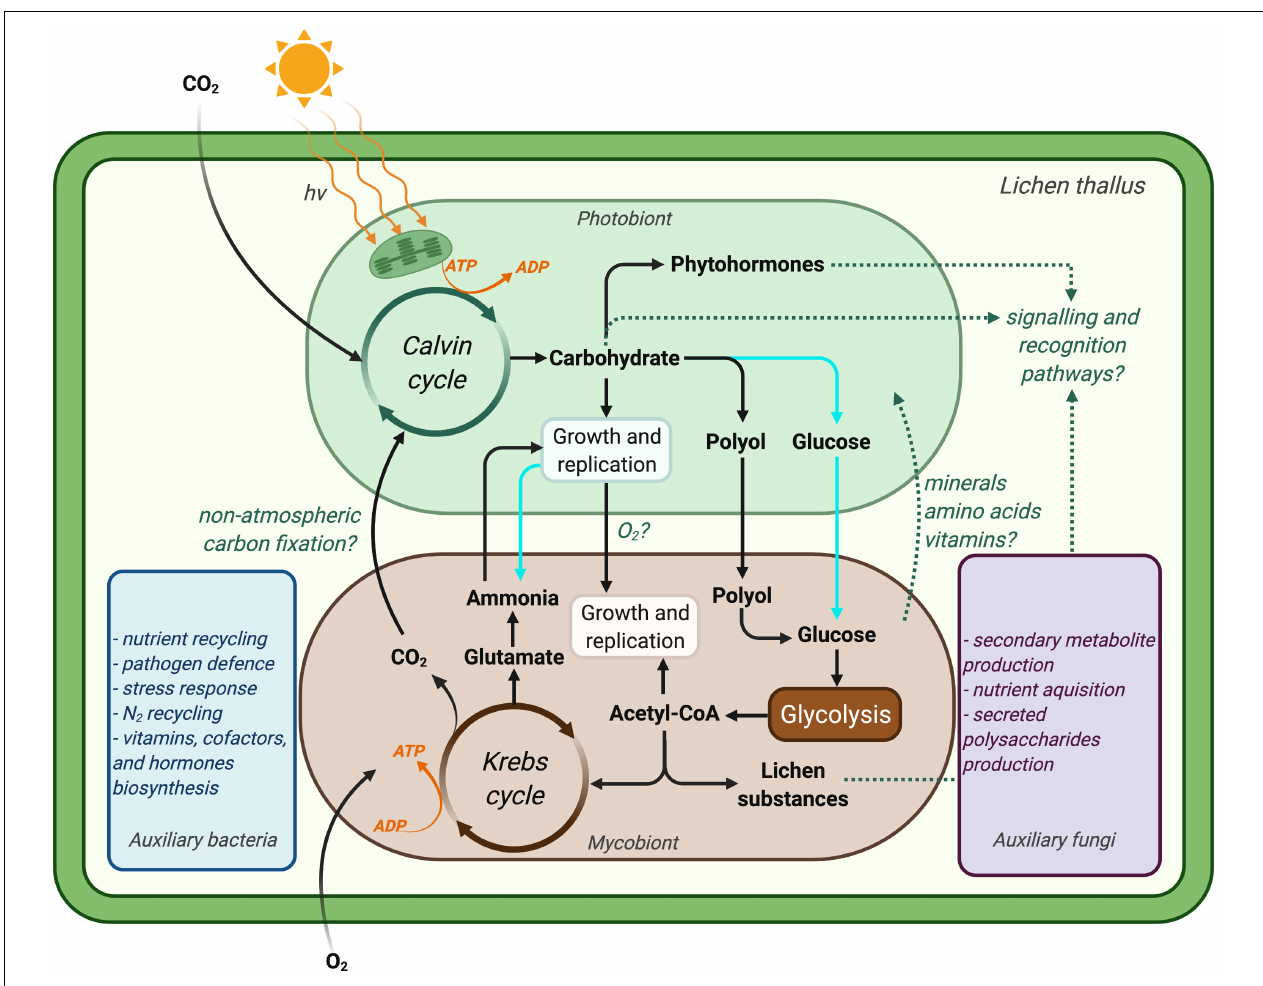
FIGURE 4 | Simplified illustration of a lichen symbiosis showing our current understanding of the metabolic interactions between lichen symbionts. Dotted line indicates knowledge gaps that may not be generalisable to all lichens. Atmospheric carbon is fixed to carbohydrates by the photobiont at the expense of ATP, which is generated by photosynthesis. Chlorolichens convert carbohydrate to polyols and transport it to their respective mycobionts, whereas cyanolichens (cyan pathways) translocate carbohydrate in the form of glucose to their mycobionts. Mycobiont metabolism is fuelled by such carbohydrate translocation, which results in the provisioning of nitrogen for the photobiont (in case for chlorolichens). Recent studies also suggest coupled metabolisms for lichen symbionts with respect to the supply of oxygen (in addition to carbohydrates) by photobionts in return for carbon dioxide from their mycobionts (Schwartzman, 2010; Hom and Murray, 2014; ten Veldhuis et al., 2020). The production of lichen substances (mainly by mycobionts) and the production of phytohormones and/or carbohydrates by photobionts are believed to play key roles in the recognition of symbionts. The proposed functions of auxiliary lichen bacteria and fungi during the symbiosis are also indicated based on comprehensive multi-omics studies (blue and purple rectangles). It is speculated that the lichen microbiome forms a biofilm on the surface of the mycobiont, through which they communicate (Image created with